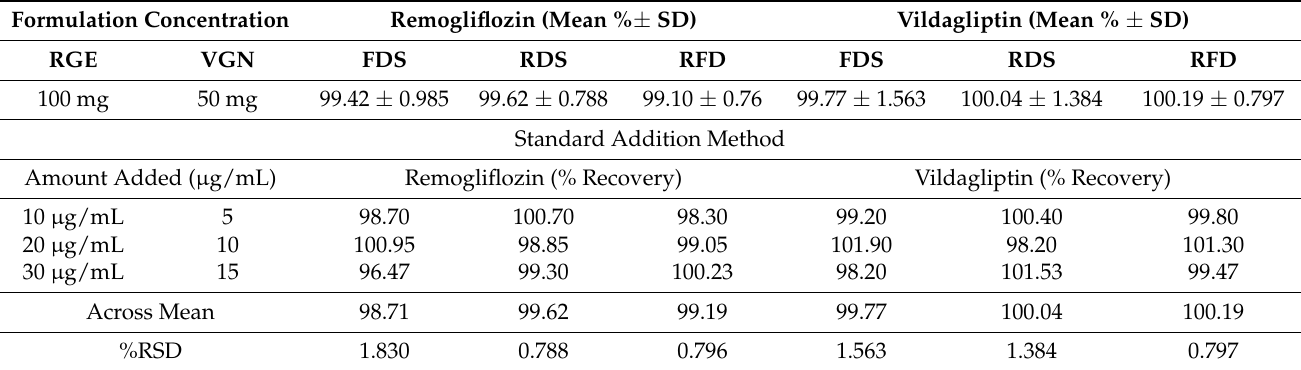
Table 3. Assay results of the formulation and the standard addition method